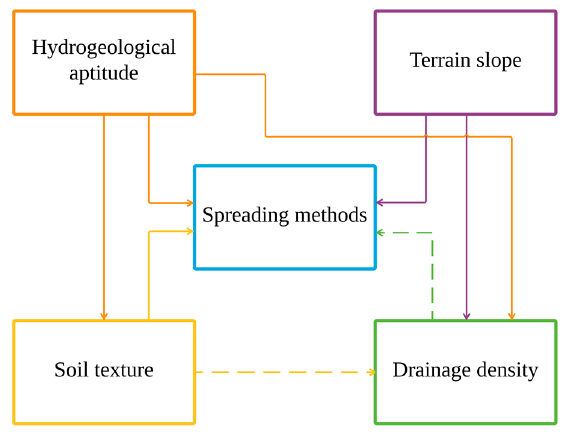
Figure 8. Interaction between the criteria for the MIF method (solid arrows represent major effects and dash arrows minor effects). Table 1. Computation of the criterion weight using the MIF method.